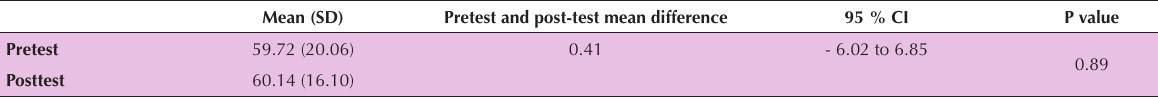
Table 2 . Mean value of correctly answered questions in pretest and posttest for WhatsApp group